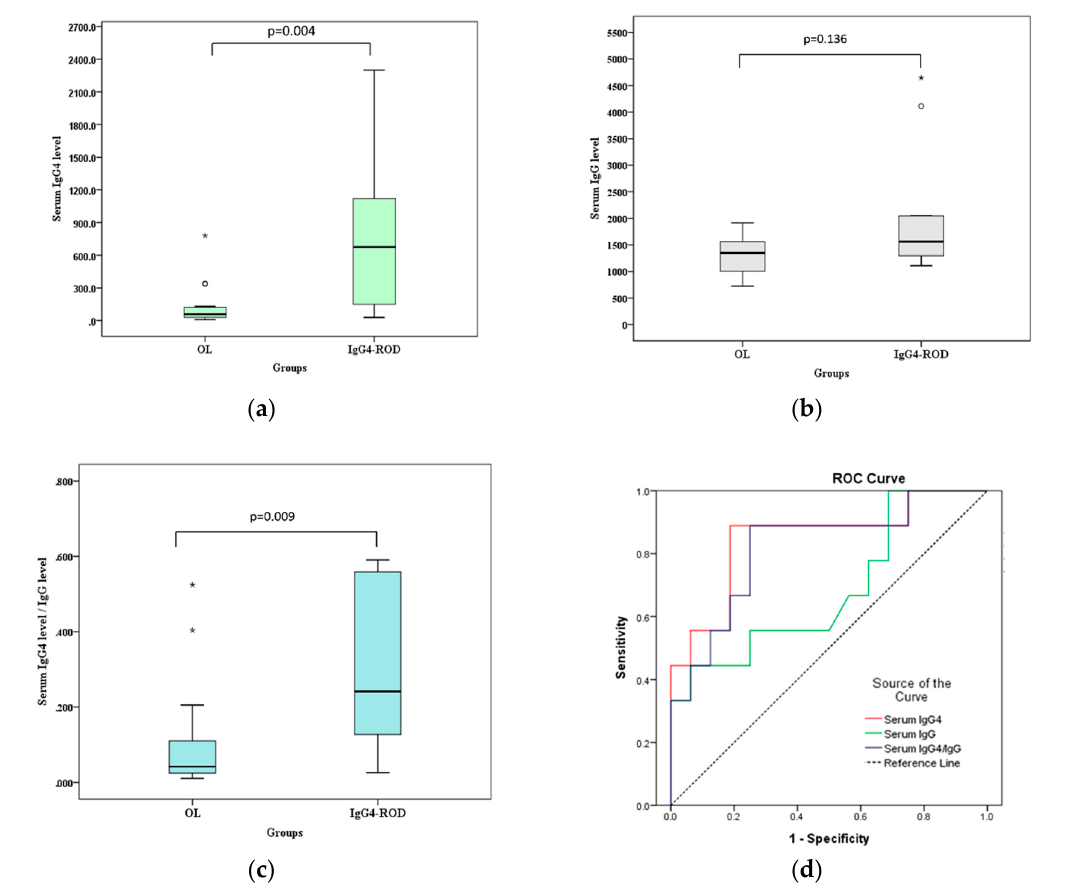
Figure 4. Box-and-whisker plots and receiver operating characteristic curve (ROC) analysis of serum immunoglobulin G4 (IgG4) levels, serum immunoglobulin G (IgG) levels and serum IgG4 level / serum IgG level ratios between orbital lymphoma (OL) and IgG4-related orbital disease (IgG4-ROD). Bars = medians. ( a ) Serum IgG4-levels demonstrate a significant di ff erence between the two groups Figure 3. Box-and-whisker plots and receiver operating characteristic (ROC) curve analysis of ( p = 0.004, Mann–Whitney U test); ( b ) Serum IgG levels demonstrate a nonsignificant di ff erence precontrastcomputedtomography(CT)Hounsfieldunitscale(CTHU),postcontrastCTHU,postcontrast CTHU / precontrastCTHUratiosbetweenorbitallymphoma(OL)andimmunoglobulinG4-relatedorbital between the two groups ( p = 0.136, Mann–Whitney U test); ( c ) Serum IgG4 level / IgG level ratios disease(IgG4-ROD).Bars = medians. ( a )PrecontrastCTHU(precontrastHU)showsanonsignificant di ff erence between the two groups ( p = 0.484, Mann–Whitney U test); ( b ) Postcontrast CTHU (serum IgG4 level / IgG level) demonstrate a significant di ff erence between the two groups ( p = 0.009, (postcontrastHU)showsasignificantdi ff erencebetweenthetwogroups( p = 0.002,Mann–Whitney Mann–Whitney U test); ( d ) The areas under the ROC curve of serum IgG4 level (serum IgG4), serum IgG U test); ( c ) Postcontrast CTHU / precontrast CTHU ratios (postcontrast HU / precontrast HU) show a significant di ff erence between the two groups ( p = 0.048, Mann–Whitney U test); ( d ) Areas under level (serum IgG) and serum IgG4 level / IgG level ratio (serum IgG4 / IgG) are 0.847 (95% CI: 0.674 to theROCcurve(AUC)ofprecontrastCTHU(precontrastHU),postcontastCTHU(postcontrastHU) andpostcontrastCTHU / precontrastCTHUratios(postcontrastHU / precontrastHU)are0.56(95%CI: 1.000, p = 0.005), 0.684 (95% CI: 0.455 to 0.913, p = 0.134) and 0.819 (95% CI: 0.639 to 1.000, p = 0.009), 0.393–0.727, p = 0.484),0.766(95%CI:0.615–0.917, p = 0.002)and0.670(95%CI:0.498–0.842, p = 0.048), respectively. * and respectively. —anoutlier. #